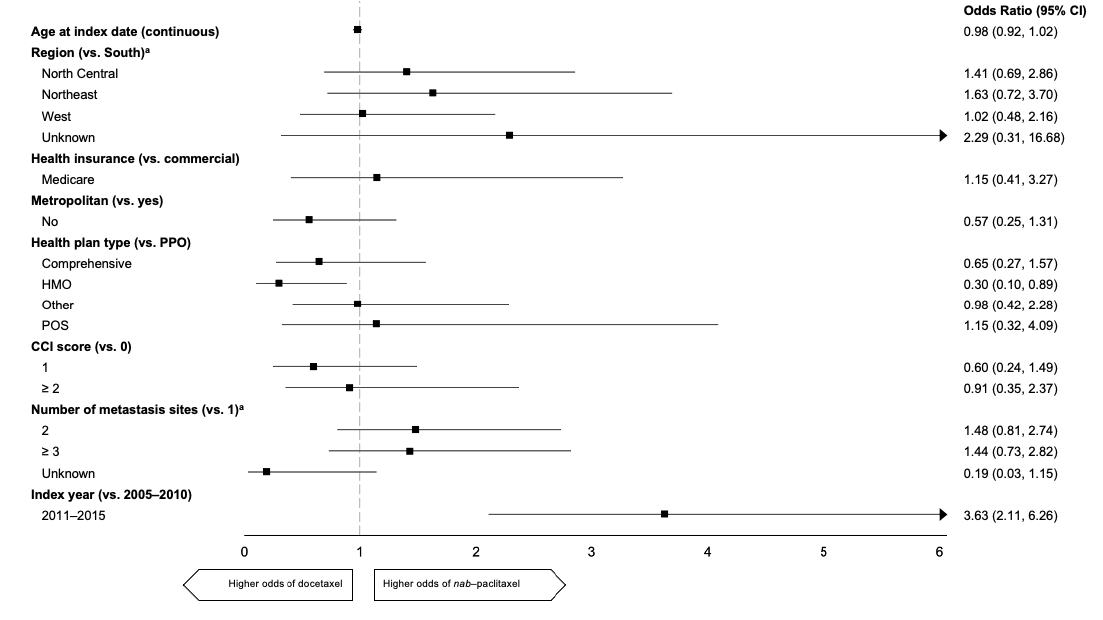
6 A: Nab -Paclitaxel versus paclitaxel.